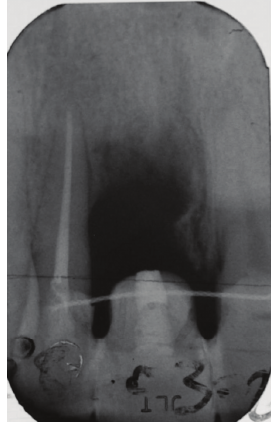
Figure 8: The radiograph taken before implant insertion shows a complete loss of the buccal and palatal